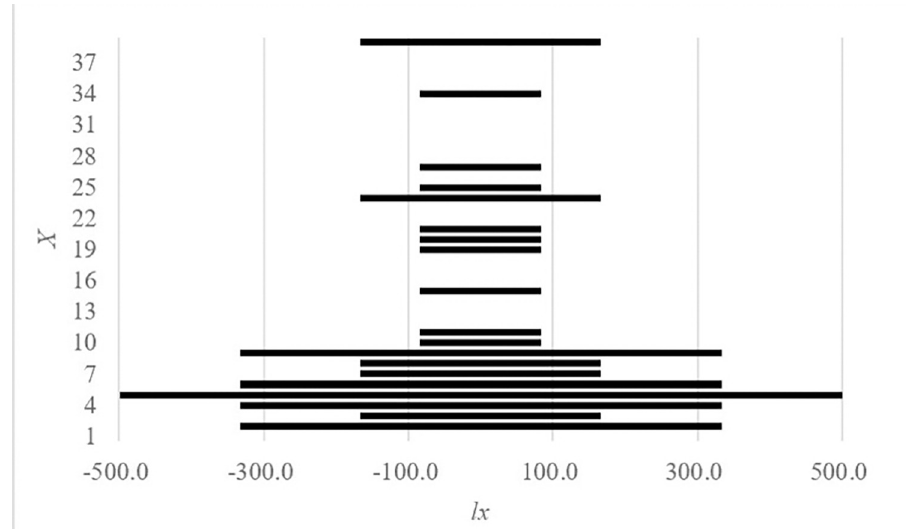
Fig 4. Age pyramid of P . flavus BM population.